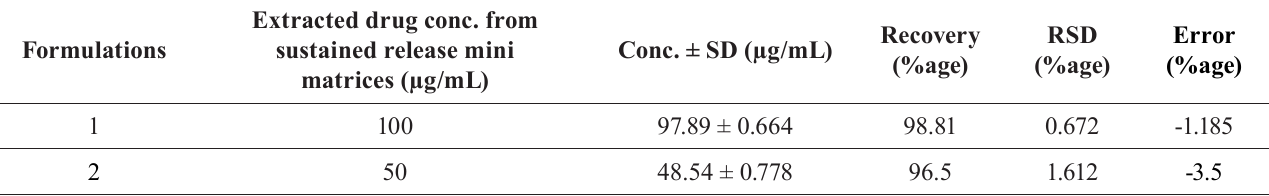
TABLE I - A ssay of Pregabalin in sustained release mini matrices Extracted drug conc. from Formulations sustained release